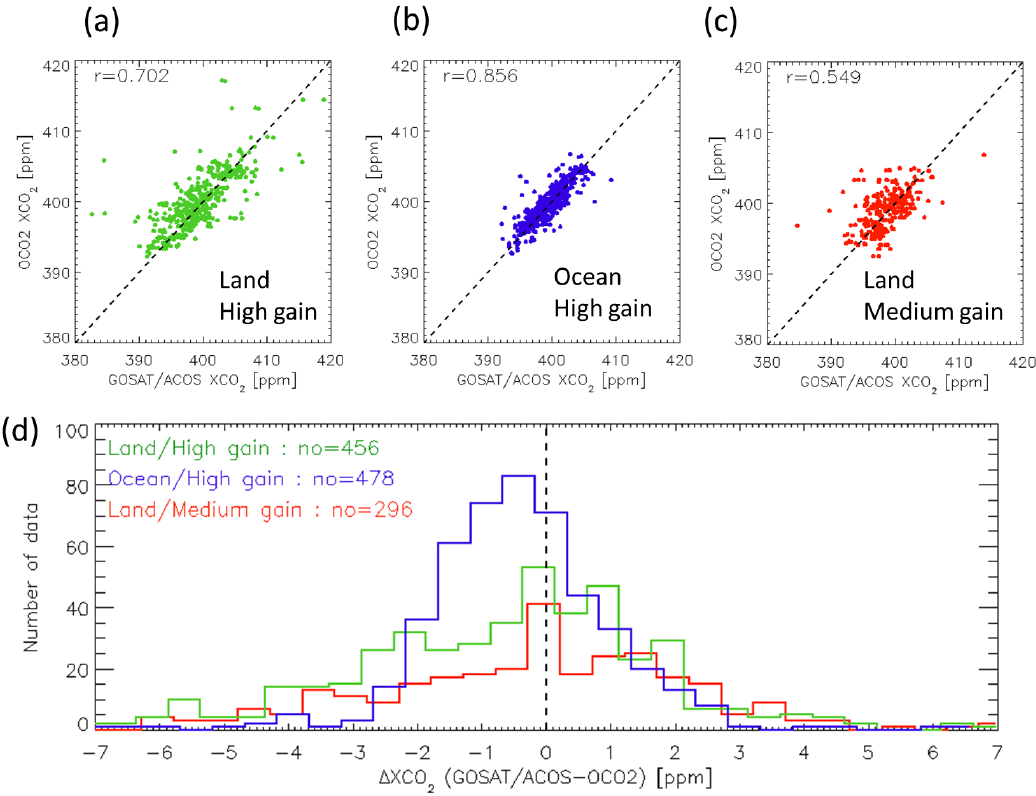
Figure 7. Correlation plots of GOSAT/ACOS XCO 2 and OCO-2 XCO 2 ( a ) over land with high gain; ( b ) over ocean with high gain and ( c ) over land with medium gain. The Pearson correlation coefficients, r, are in the upper left of each figure; ( d ) Histogram of ∆XCO 2 for each observation mode. The bin size of the histogram is 0.5 ppm. The mean biases and standard deviations are ( a ) −0.57 ± 3.33 ppm, ( b ) −0.17 ± 1.48 ppm and ( c ) −0.19 ± 2.79 ppm.